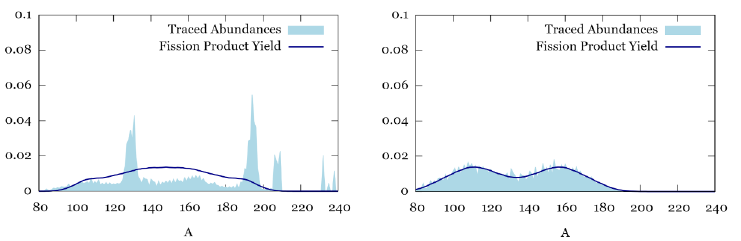
Figure 3. Comparison of mass distribution of fission products immediately after fission occurs (blue line) and after they participate in all subsequent r process nucleosynthesis (light-blue filled curve). The left panel corresponds to the neutron-induced fission of Plutonium 295; this nucleus fissions relatively early during nucleosynthesis, so its fission products undergo a significant amount of subsequent nucle- osynthesis. The right panel corresponds to the β − -delayed fission of Berkelium 268; in this case, fission occurs at a much later time during nucleosynthesis, and the products’ contribution to nucleosynthesis is closely tied to its product yield